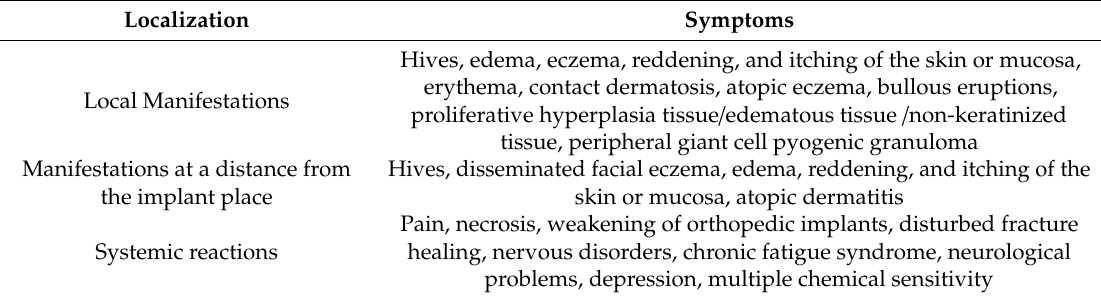
Table 3. Clinical manifestations of hypersensitivity to